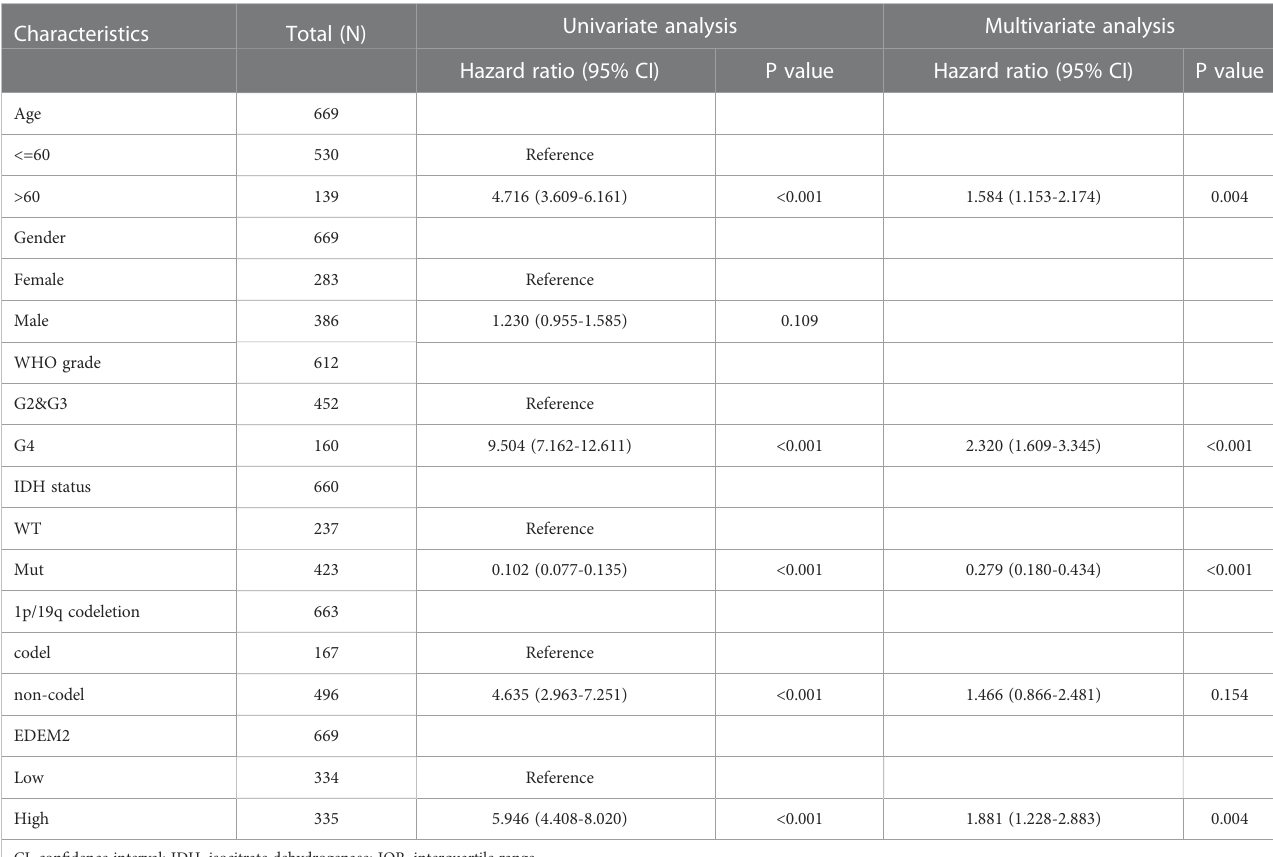
TABLE 2 Univariate and multivariate Cox analysis results in the TCGA cohort.